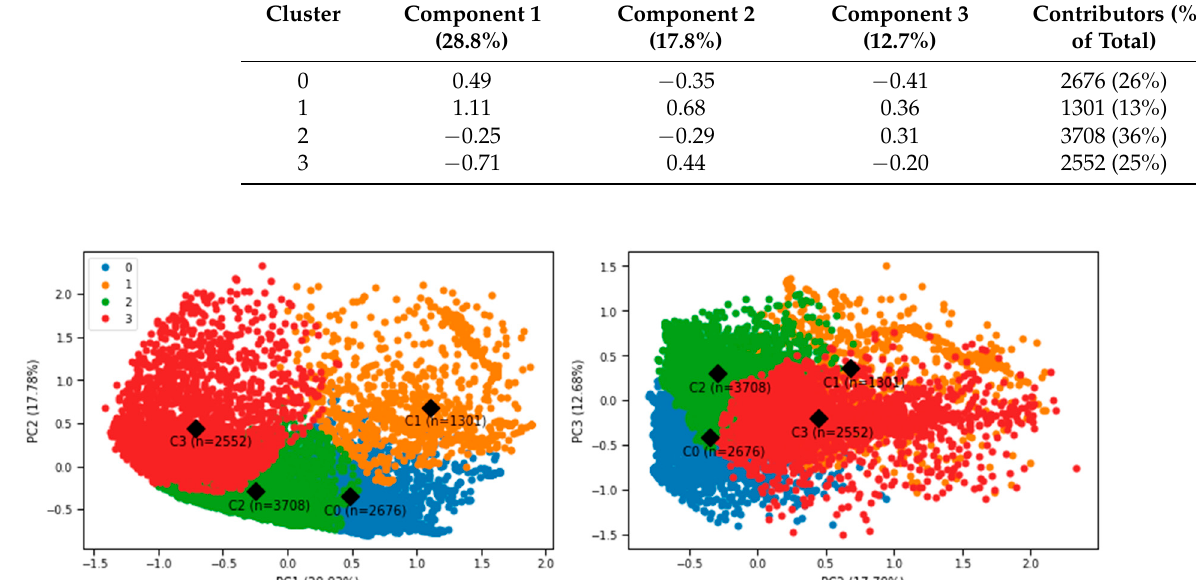
Figure 6. Cluster solution with three principal components.